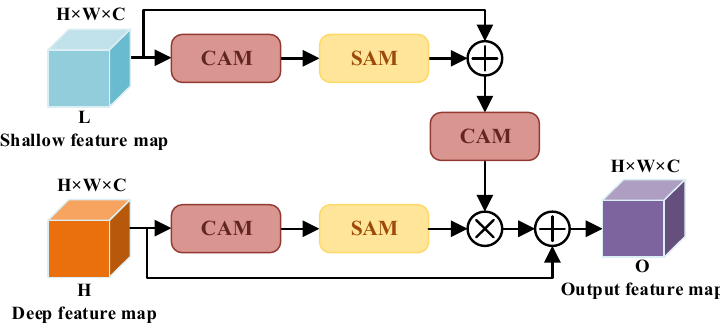
Figure 6. Attention feature fusion module.